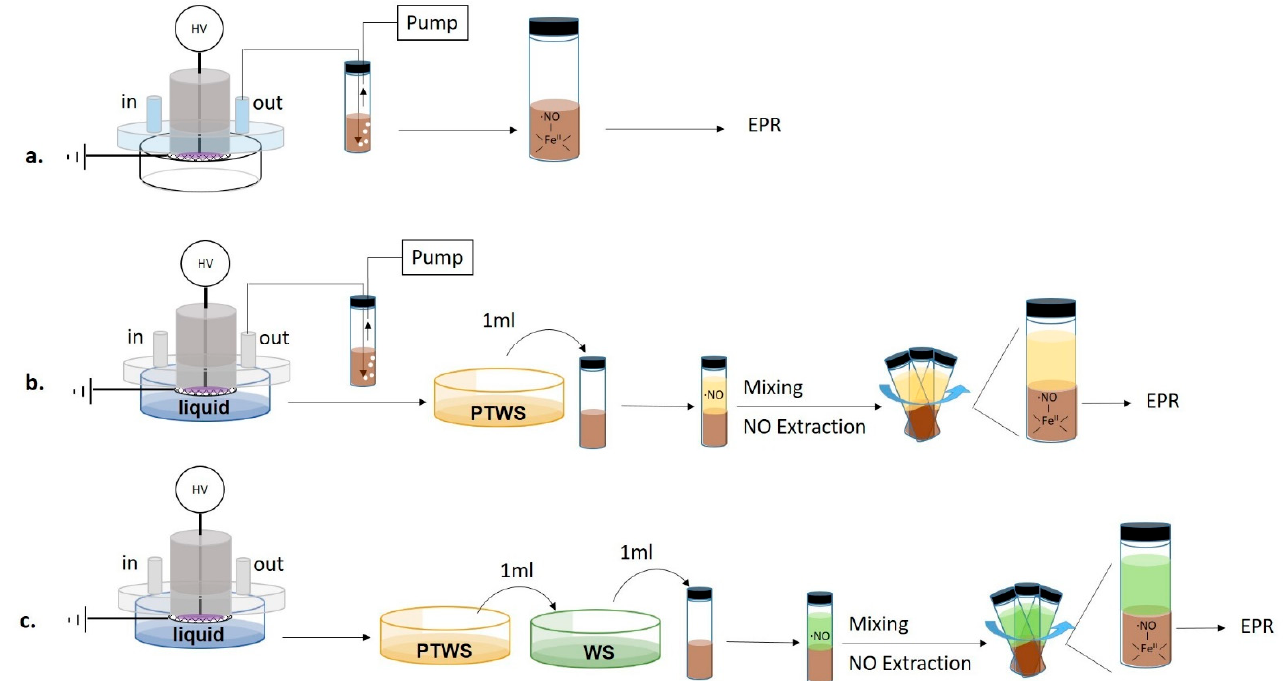
Figure 2. Scheme of the experimental procedures used for the Electron Paramagnetic Resonance (EPR) detection of nitric oxide. ( a ) Detection of nitric oxide ( ● NO) in plasma effluents without the liquid ( b ) Contemporary detection of ● NO in plasma effluents and PTWS. ( c ) Detection of ● NO in PTWS after mixture with untreated Water Solutions (WS) before the trapping step.